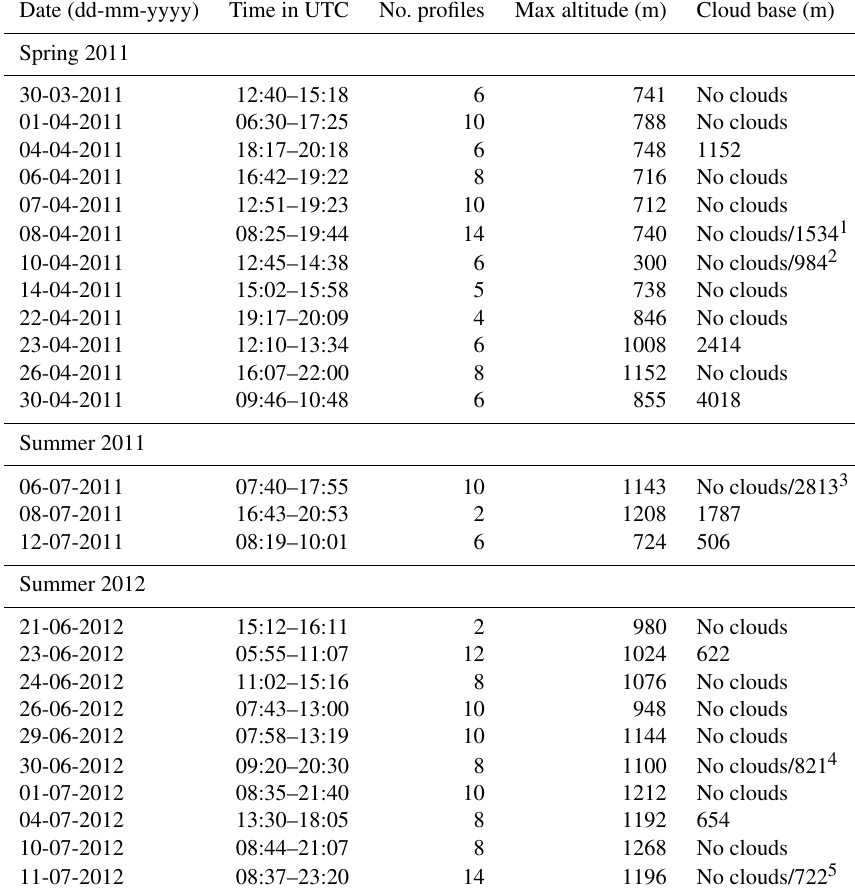
Table 1. Dates, UTC, number of profiles, maximum altitude and sky conditions reached during the 2011–2012 spring–summer campaign in